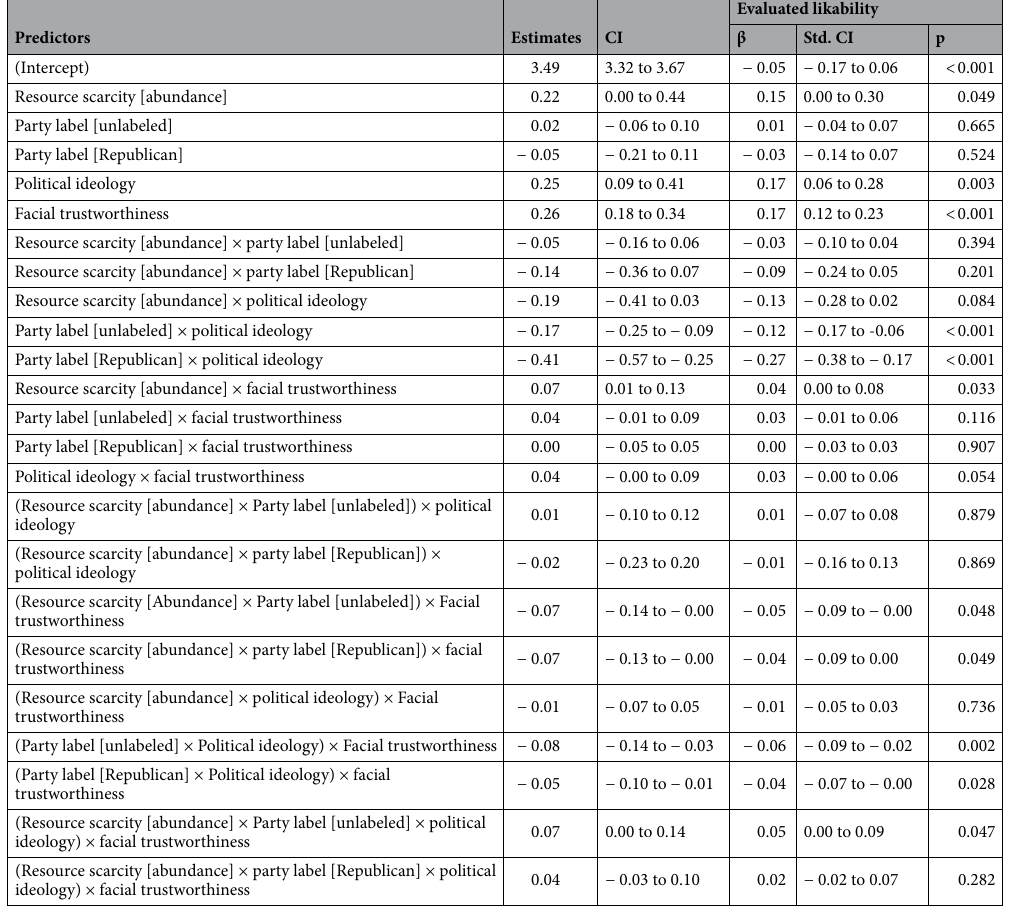
Table 6. Mixed effects model predicting likability in experiment